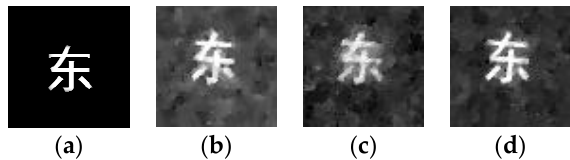
Figure 5. Results obtained by the single-pixel camera: ( a ) target image; ( b ) recovered images using logistic chaotic sequence (LCS-MM), PSNR = 10.60 dB, SSIM = 0.10; ( c ) recovered images using LCS-CMM, PSNR = 9.07 dB, SSIM = 0.06; ( d ) recovered images using LCS-PRC-MM, PSNR = 12.98 dB, SSIM = 0.11.